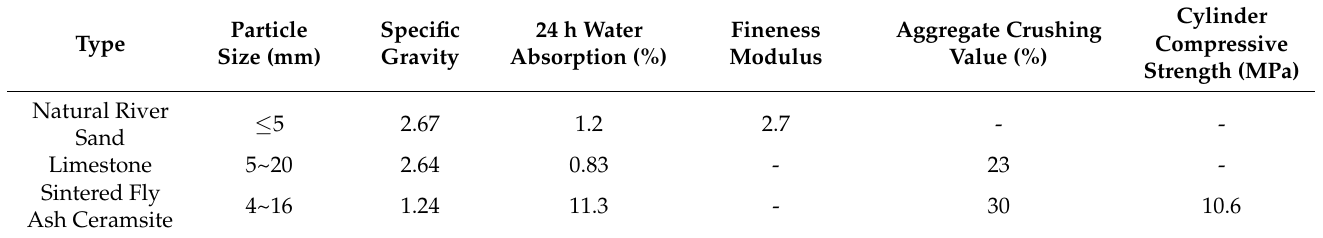
Table 2. Physical properties of the coarse and fine